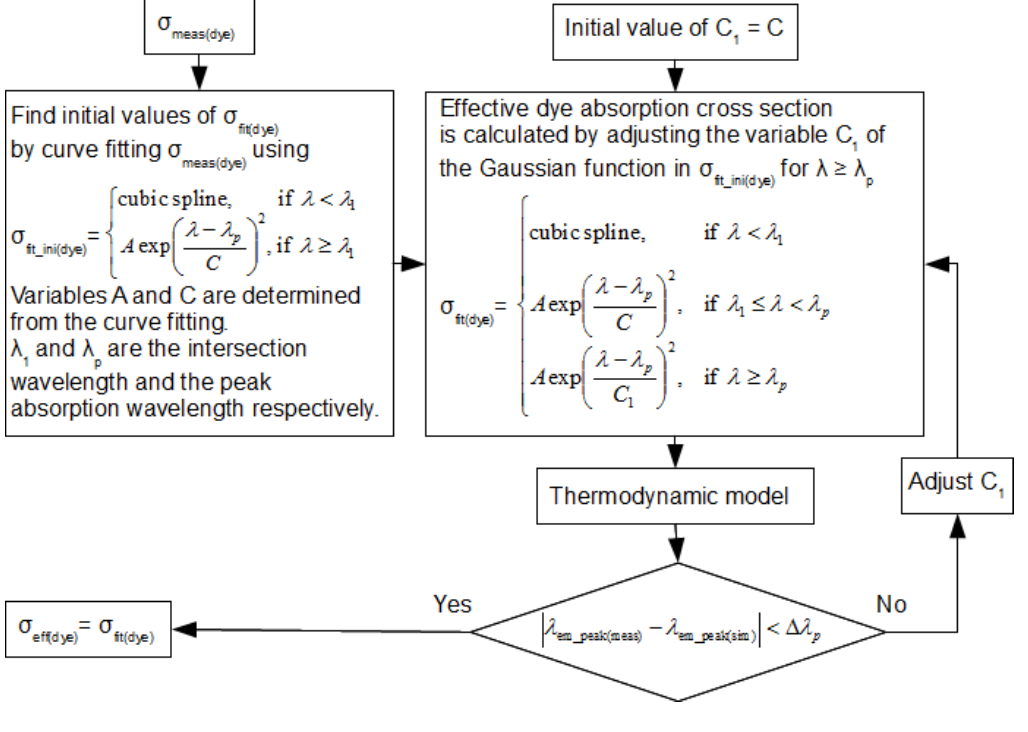
Figure 11. Flow chart for calculating the effective absorption cross section of the dye.